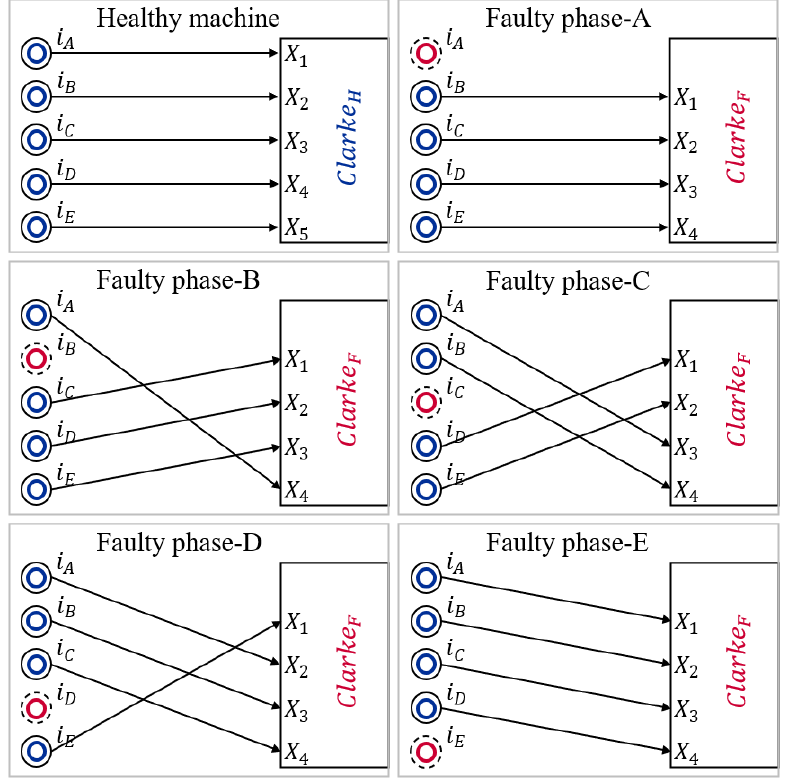
Figure 5. Updating of the input vector of the Clarke transformation depending on the OPF situation.